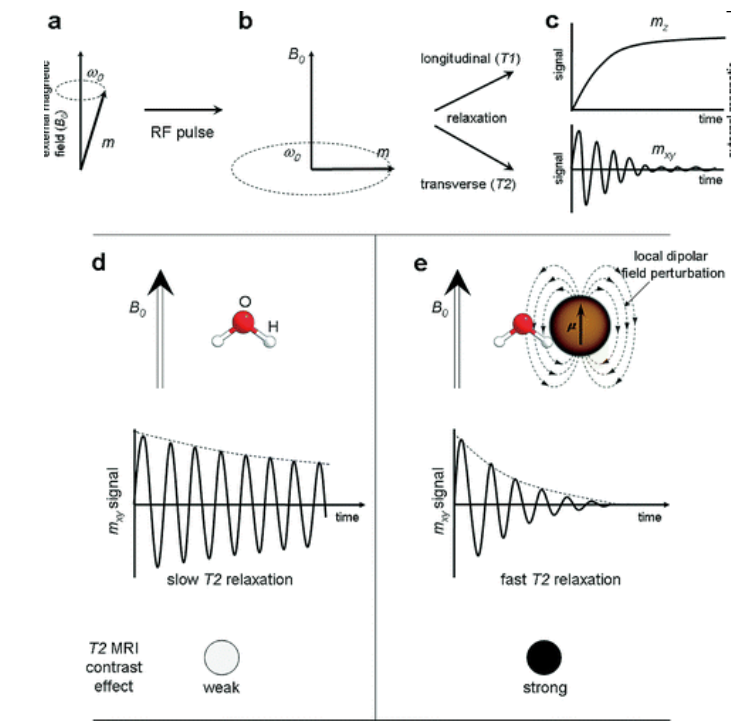
Fig. 2 Illustration of the magnetic resonance (MR) principle and the role of magnetic nanoparticles as a contrast agent: (a) net magnetic spins ( m ) of water protons precess with a Larmor frequency ( ω ); (b) upon applica- tion of a RF pulse, m begins precessing perpendicular to B0; (c) m relaxes back to its original equilibrium states through longitudinal (T1, m z) and transverse in-planar (T2, m ) modes; (d) for in-planar (T2) relax- ation mode without magnetic nanoparticle, water protons have a relatively slow relaxation time with a weak MR contrast effect; (e) in the presence of magnetic nanoparticles, protons inside the local dipolar field per- turbation area around the nanoparticle relax faster with a strong MRI signal, which produces strong MR con- trast effects. （ Reprinted, with permission, from Reference 〔 151 〕） , Copyright American Chemical Society. [ テキストを入力 ]